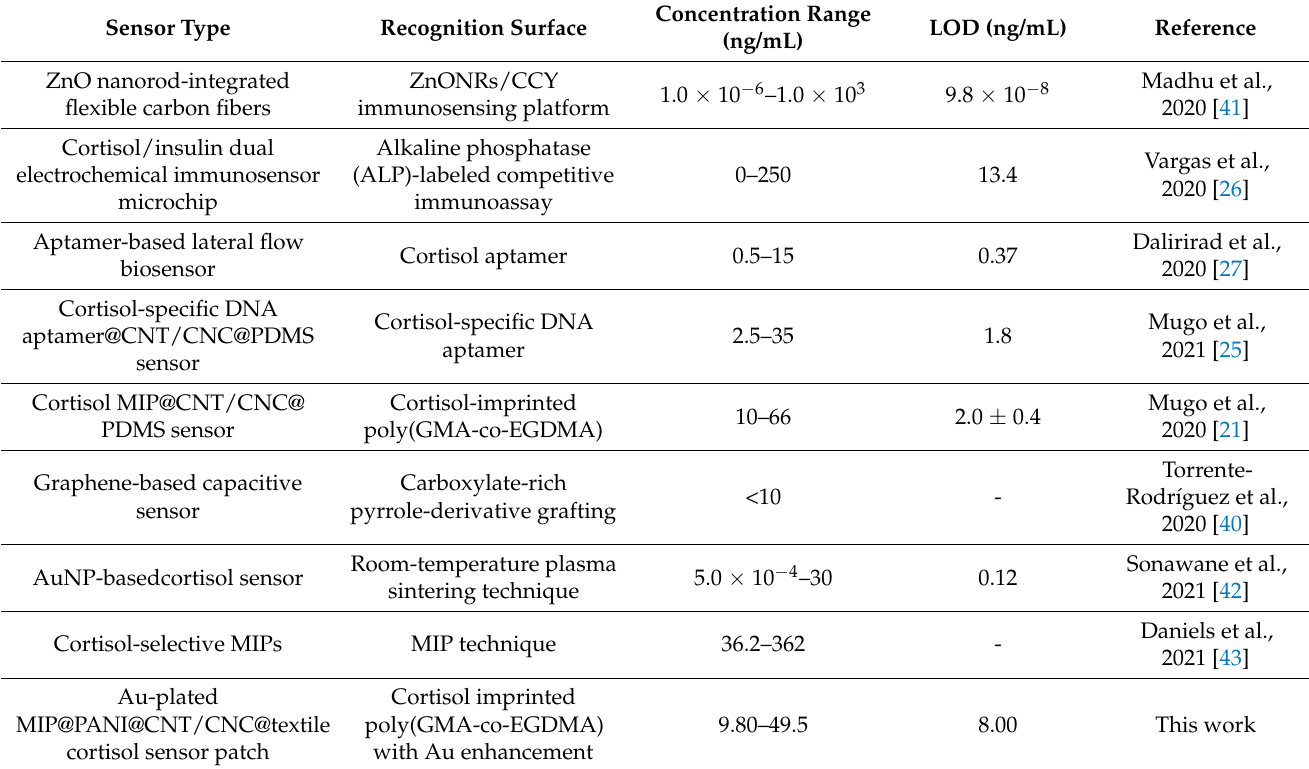
Table 2. Literature comparison of cortisol sensor performance metrics to the reported